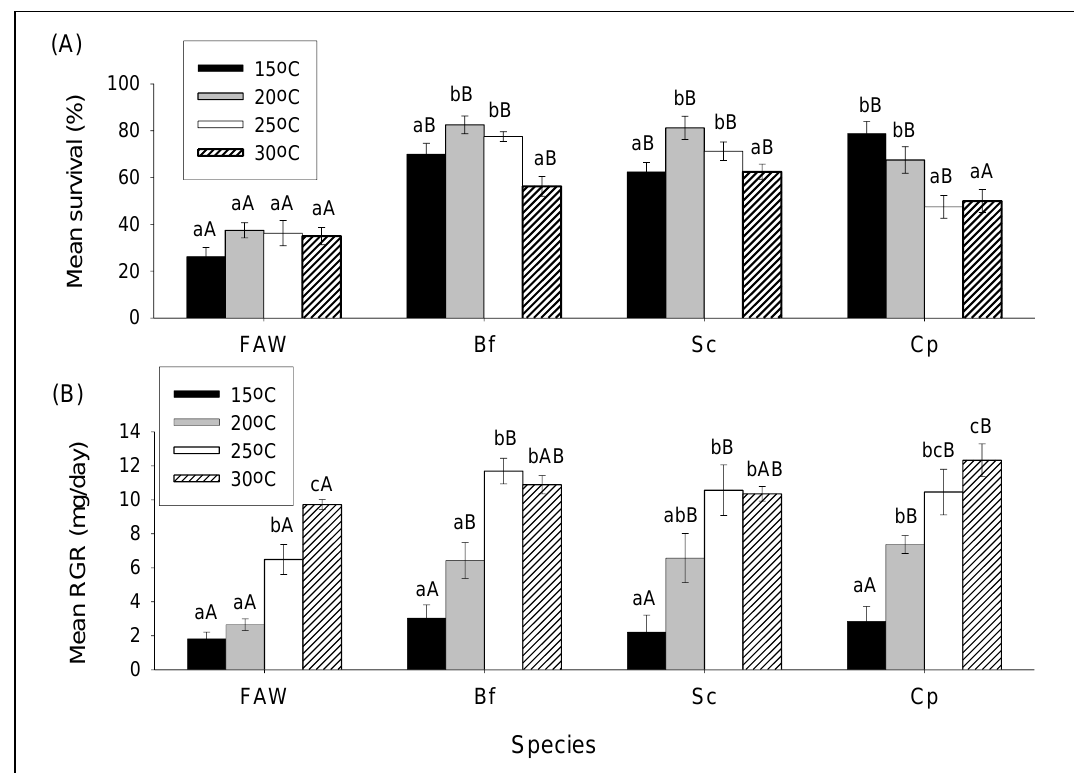
Figure 2. Comparison of survival ( A ) and relative growth rate ( B ) of S. frugiperda (FAW), B. fusca (Bf), S. calamistis (Sc), and C. partellus (Cp) in single-species combinations at di ff erent constant temperatures. Means ( ± SE) with di ff erent letters are significantly di ff erent, determined using Tukey’s multiple comparisons tests performed with lsmeans R package [21], following generalized linear model (GLM) with binomial error distribution for survival or False Discovery Rate (FDR) [22] with lsmeans R package [21], following analysis of variance (ANOVA) after constructing general linear models for relative growth rates. Small letters were used to compare means between temperatures for each species and capital letters to compare means between species for each Table 1. Result of GLM analysis comparing larval survival of each single-species at different constant temperature and at each temperature between species. Statistic Values Between Temperatures Between Species